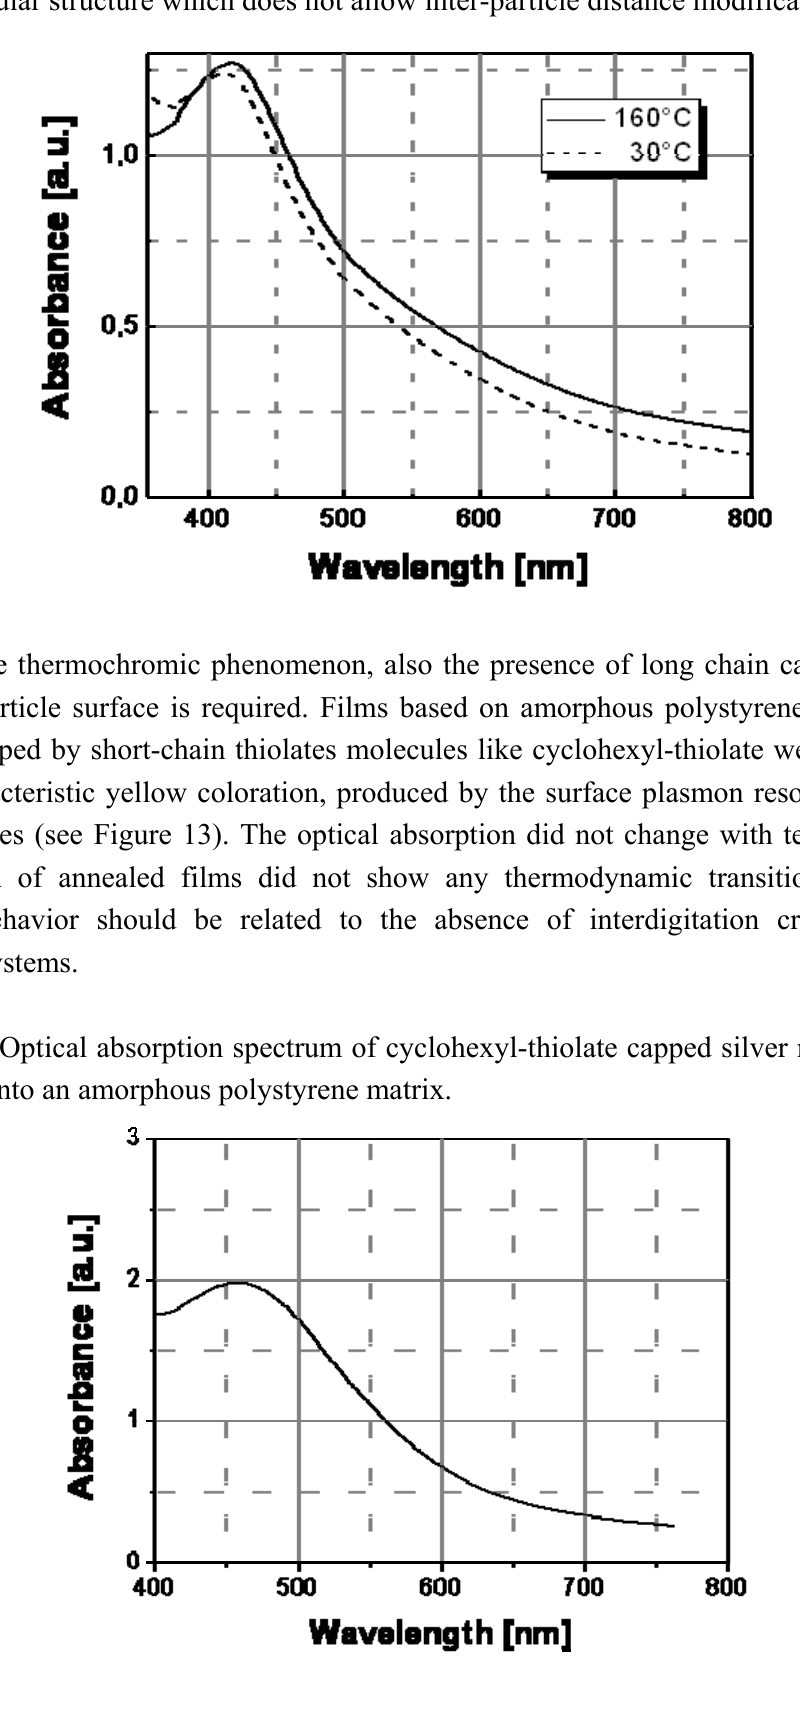
Figure 12. Dodecyl-thiolate capped silver nanoparticles embedded into epoxy, showing a stable surface plasmon coloration. The absence of thermochromism should be related to the rigid molecular structure which does not allow inter-particle distance modification.